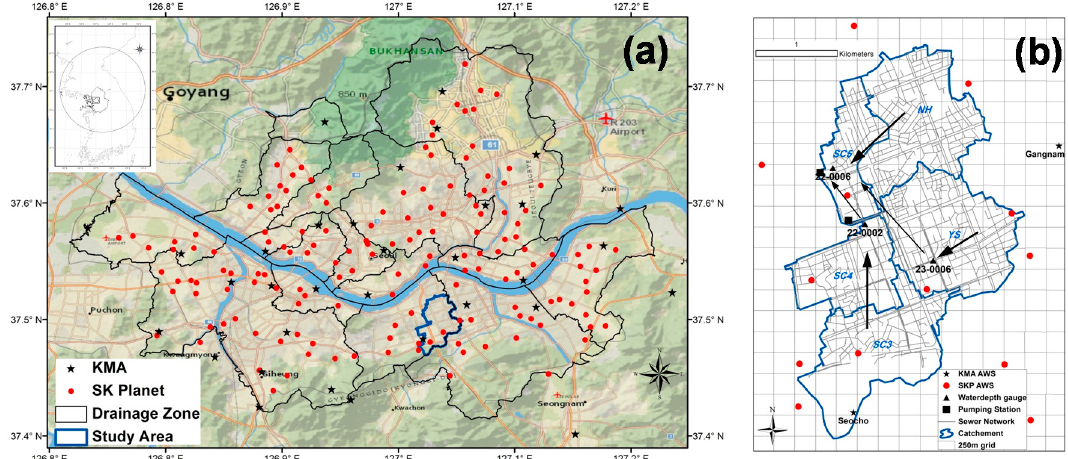
Figure 1. ( a ) The boundary of Seoul metropolitan area for which quantitative precipitation estimation (QPE) products were obtained and the study area rain gauge stations of the Korea Meteorological Administration (KMA) (black stars) and SK Planet (red circles); ( b ) drainage system and observation stations of rain and water depth (black triangles).